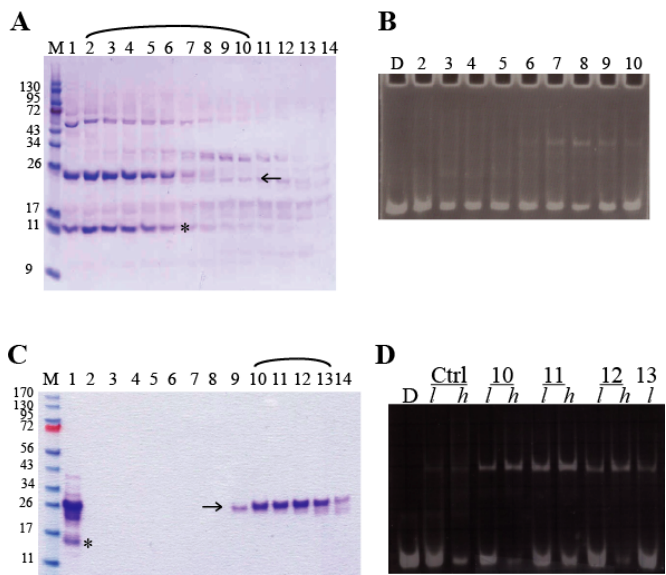
Figure 2. The best protocol of purification of untagged miniAdr1-BL. ( A ) The 4–12% gradient SDS-PAGE of the purification step on a CM sepharose column. Lane M: molecular weight markers (Fermentas, Thermo fisher Scientific, Milano, Italia). Lanes 1–14: fractions eluted at NaCl concentration between 0.5 and 1 M. Arrows and stars indicate miniAdr1-BL and KpCyt c, respectively. ( B ) Analytical DNA binding assays on fractions separated by CM sepharose (arch in Panel A). All fractions were reacted with half site dsDNA and stained with ethidium bromide. Lane D: free DNA. Lanes 2–10: CM column fractions corresponding to lanes 2–10 of Panel A. miniAdr1-BL is present in lanes 6 to 10. ( C ) The 12% SDS-PAGE after the second SEC-HPLC step. Fractions of CM column corresponding to lanes 6–10 of panel A were pulled, concentrated, and run twice on SEC-HPLC. Lane M: molecular weight markers (in kDa). Lane 1: input of the second HPLC step (coming from the peak of the first SEC). Lanes 2–14: fractions eluted from the second chromatographic step. ( D ) DNA-binding assay of the fractions separated by the second HPLC step (lanes 10–13 from panel C). Lowercase “l” and “h” refer to low (5 µ L) and high (8 µ L) volumes of protein solution in the binding assay. Lane D: half-site-free DNA probe. Lane Ctrl: previously purified miniAdr1-BL (positive control).